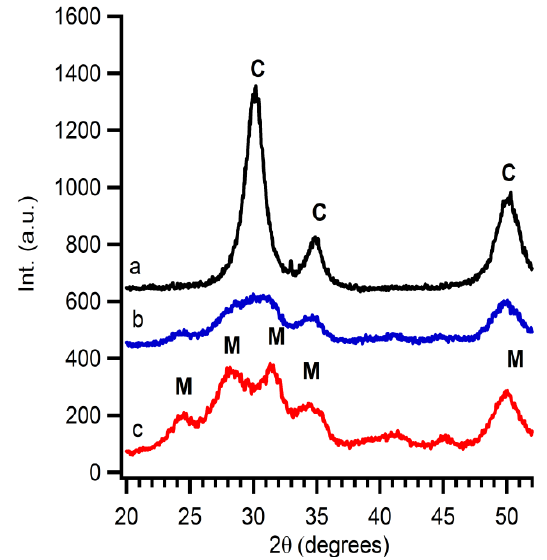
Figure 5. The influence of the temperature on the diffusion of Y into ZrO shown by XRD measurements ( a ) treated at 400 °C for 1 h; ( b ) treated at 300 °C for 1 h; and ( c ) as-synthesised, M marks the diffraction peaks of monoclinic ZrO diffraction peaks of